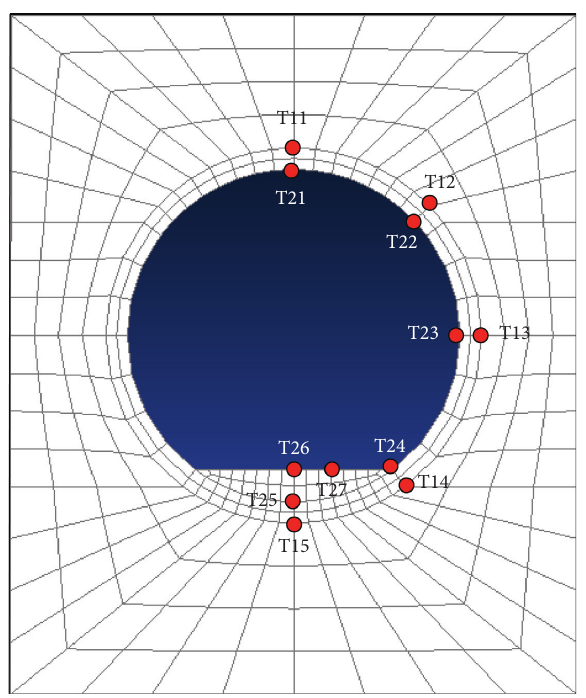
Figure 24: Representative nodes on the track bed and the tunnel